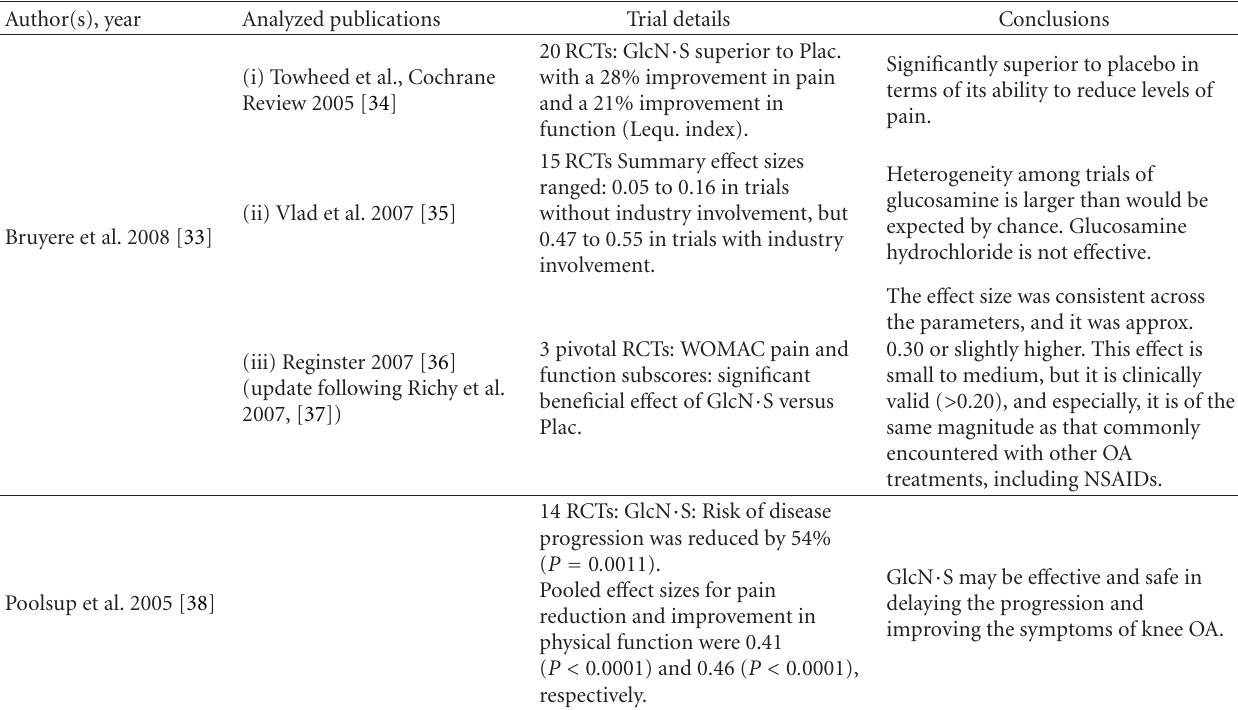
Table 2: Characteristics and results of selected